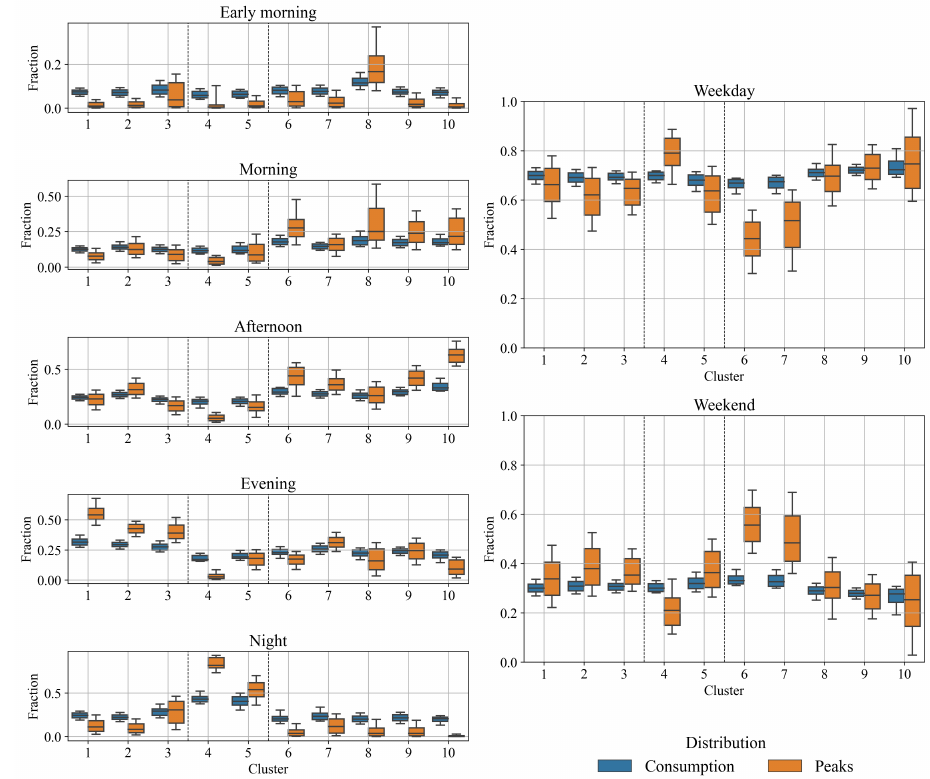
Figure 8. Boxplots visualizing the distribution of the 14 untransformed features for 10 clusters, with the 10 features at the daily level displayed on the left and the 4 features at the weekly level on the right. The whiskers of the boxplots describe the [10, 90]